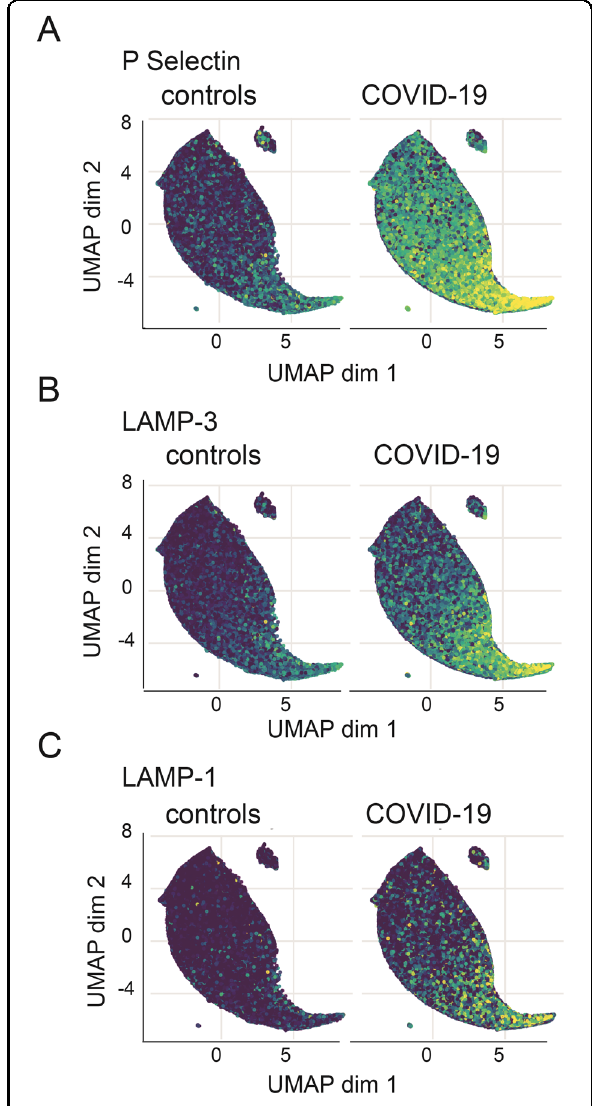
Fig. 1 Activation marker expression in non-stimulated platelets. Uniform manifold approximation and projection (UMAP) after equal random sampling from each sample and scaled, arcsinh-transformed expression [0 – 1] for each activation marker colored according to the expression level: A P-Selectin, B LAMP-3, and C LAMP-1, N = 8 COVID- 19 patients, 11 healthy